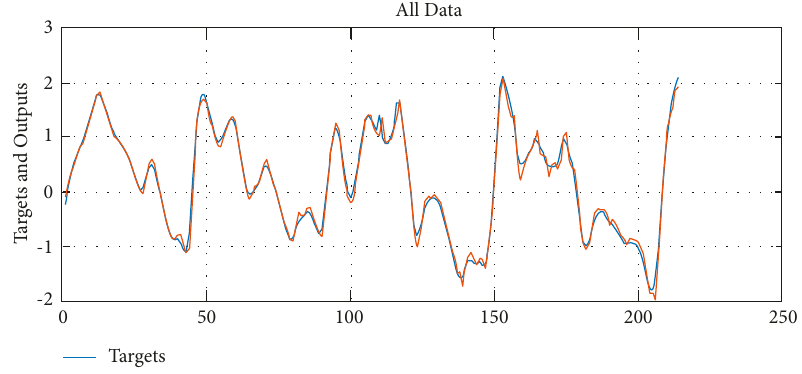
Figure 5: All data set mix